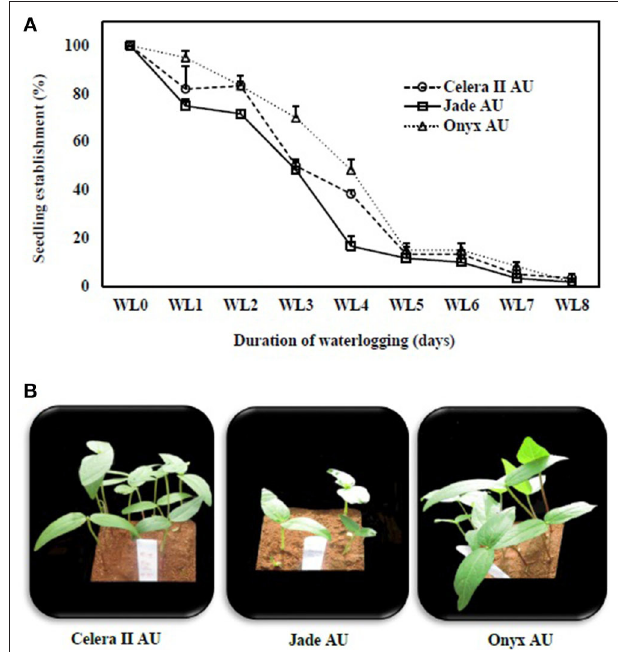
FIGURE 2 | Seedling establishment (%) of (A) mungbean ( ◦ ) Celera II-AU, ( (cid:3) ) Jade-AU and blackgram ( 1 ) Onyx-AU after different durations of waterlogging (WL0, drained control; WL1, waterlogging for 1 day; WL2, waterlogging for 2 days; WL3, waterlogging for 3 days; WL4, waterlogging for 4 days; WL5, waterlogging for 5 days; WL6, waterlogging for 6 days; WL7, waterlogging for 7 days; WL8, waterlogging for 8 days) and subsequent recovery days. Symbols are the mean ± SE of three replicates. (B) Photographs of fully emerged seedlings of the same genotypes after 4 days of waterlogging and subsequent 8 days of recovery.